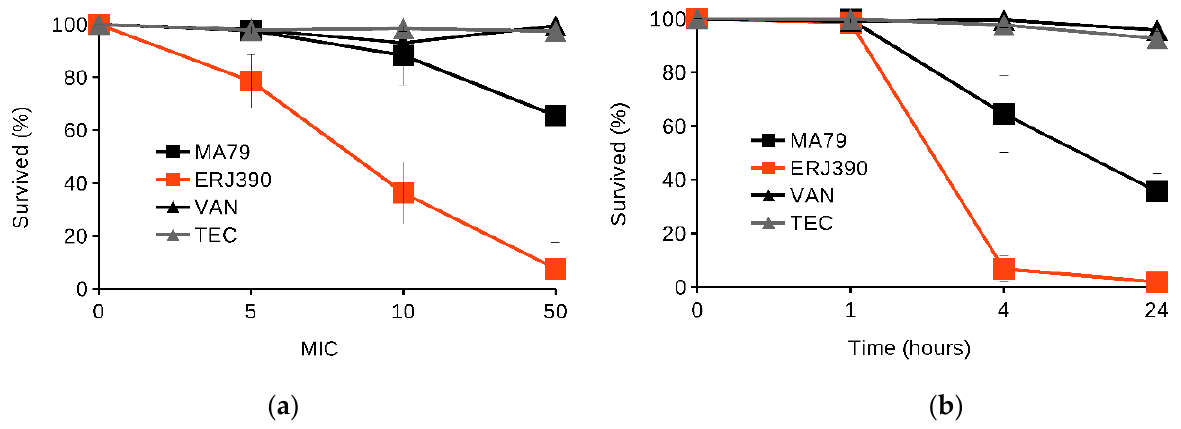
Figure 6. Killing of S. aureus cells in biofilm at different concentrations of antibiotics above MICs after four hours of incubation ( a ). Killing of S. aureus cells in biofilm at concentrations of the antibiotics 50 times higher than the MICs after different incubation times ( b ).